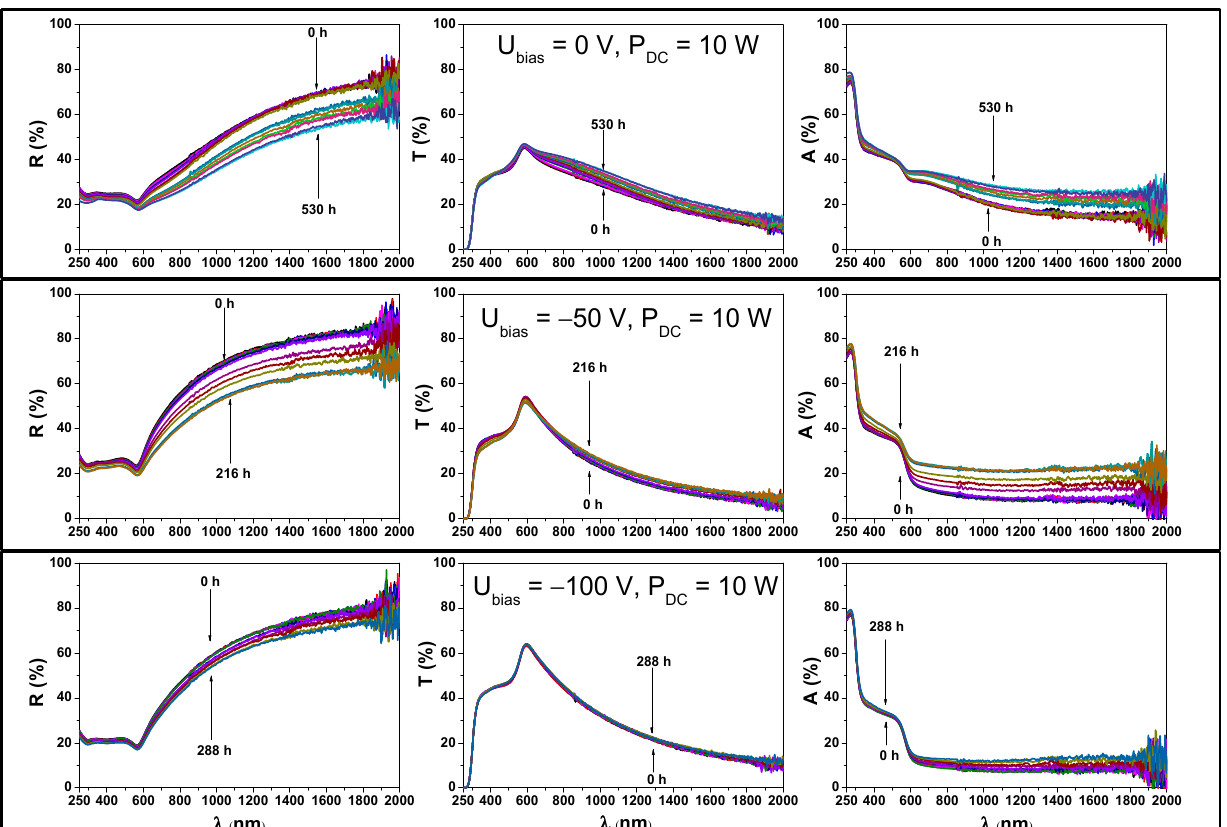
Figure 4. Refractive indices ( a ) and extinction coefficients ( b ) of copper films in DCMS and HiPIMS mode derived from transmission and reflectance spectra.